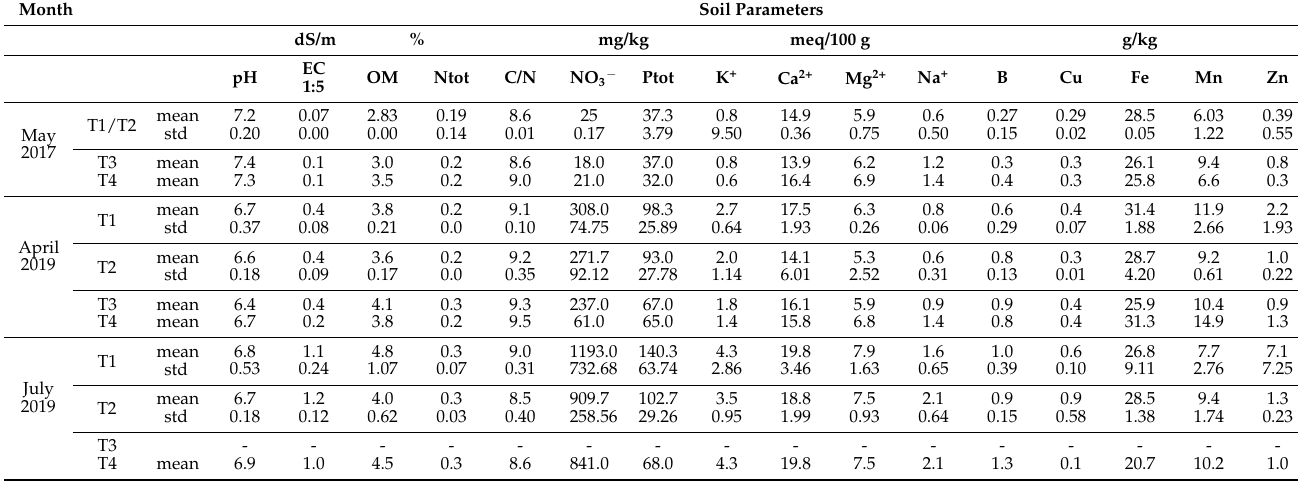
Table 2. Determination of soil pH, electrical conductivity 1:5 (EC, dS/m), organic matter (OM, expressed in %), total nitrogen (N tot, expressed in %), C/N ratio, nitrate (expressed in mg/kg, available phosphorus (P, expressed in mg/kg), extracted cations (expressed as meq/100 g): potassium (K), calcium (Ca), magnesium (Mg), sodium (Na), and the rest of analyzed nutrients (expressed in mg/kg): boron (B), copper (Cu), iron (Fe), manganese (Mn) and zinc (Zn), full irrigation (T1) and less water than T1 (T2), support irrigation (T3) and rainfed (T4), expressed by mean and standard deviation (when